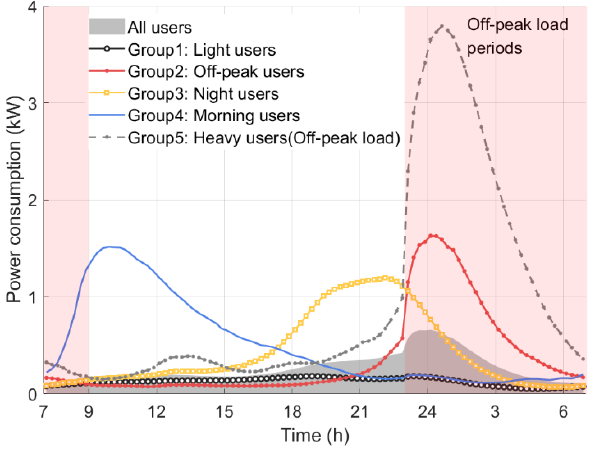
Figure 4. Representative demand profiles of EV user-segmented groups.